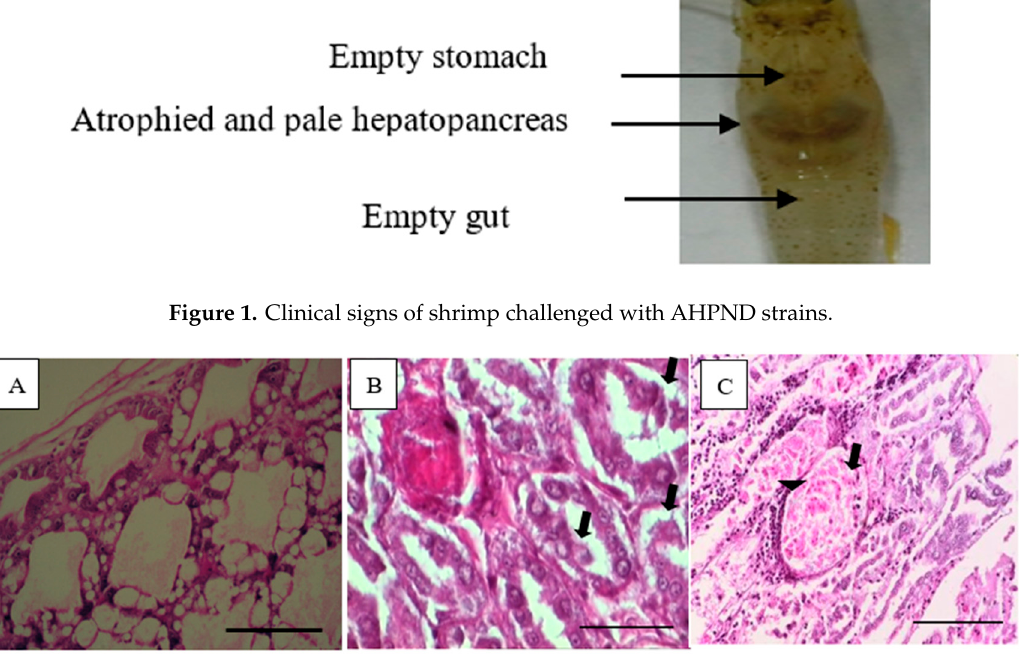
Table 3. Antimicrobial resistances of Vp AHPND strains ( n = 16).